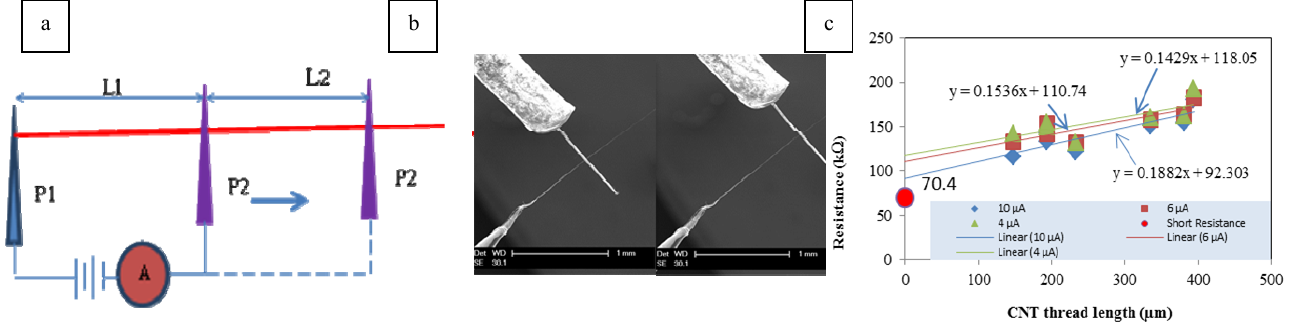
Figure 2. Experimental setup for measuring electrical resistance: ( a ) sketch of measurement method; ( b ) sliding the probe along the nanothread; ( c ) graph used to determine contact